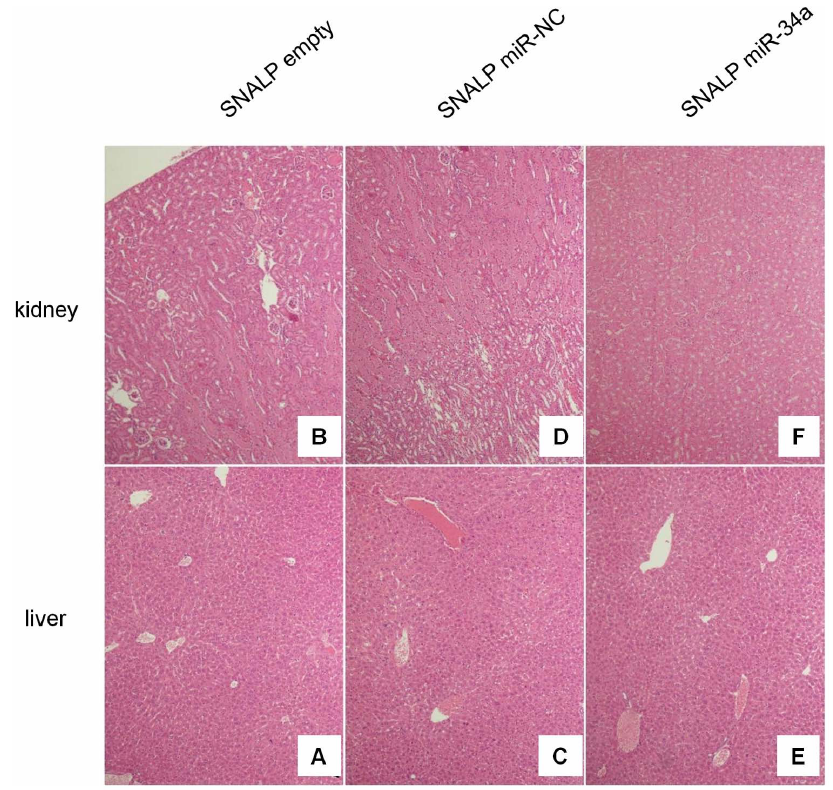
Figure 5. H&E staining of livers and kidney indicates absence of systemic toxicity. Hematoxylin and eosin staining (40-fold magnification) of kidney and liver retrieved from SNALP empty (A, B), SNALP miR-NC (C, D) and SNALP miR-34a (E, F) treated mice, respectively. No significant damage was detected in the different groups of treatment. Representative image are shown.